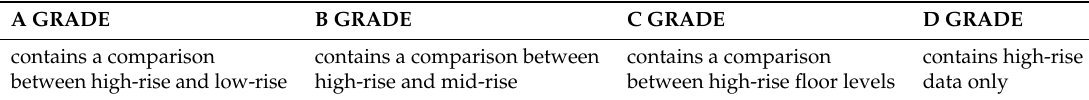
Table A1. Key paper grading criteria of high-rise apartment